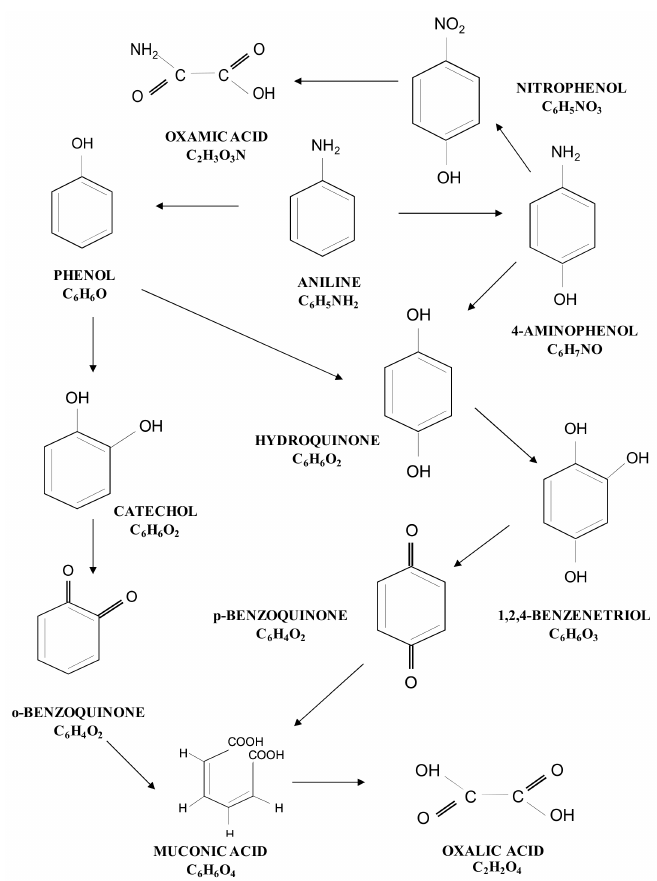
Figure 8. Oxidation pathway proposed for aniline oxidation via catalytic ozonation with TiO 2 / GAC